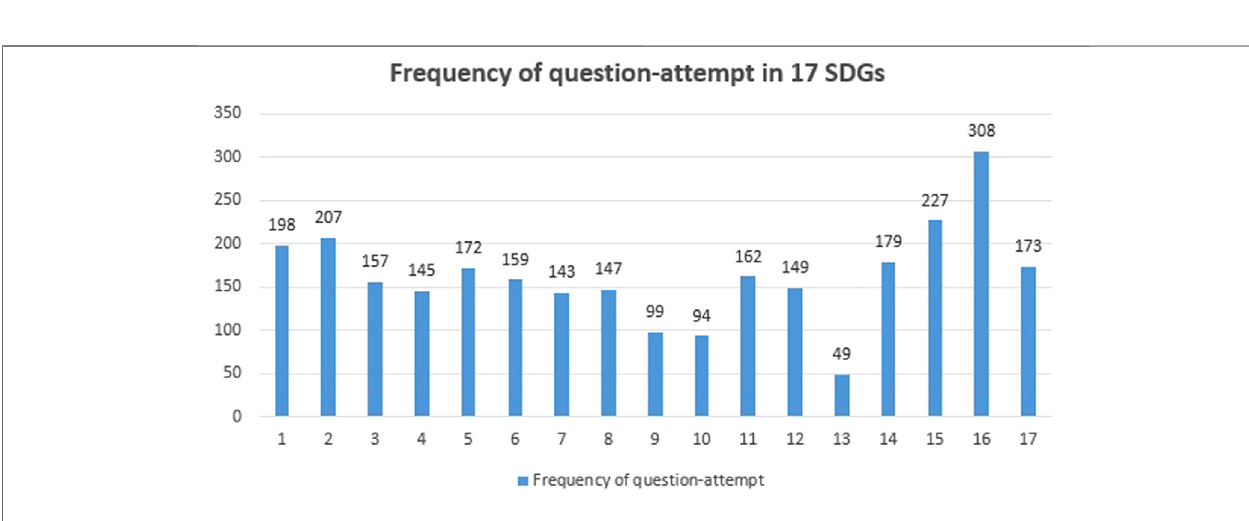
FIGURE 5 | Frequency of question attempts in 17 SDGs.